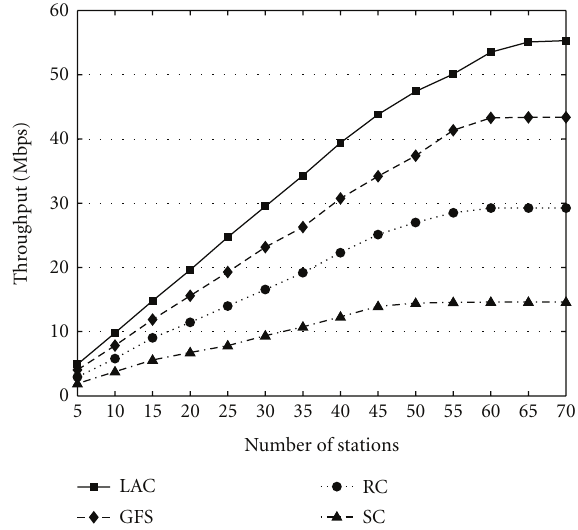
Figure 3: Total network throughput versus number of clients.